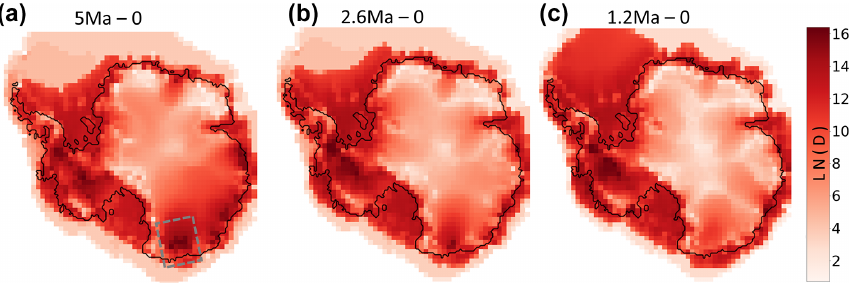
Figure 6. Spatial patterns in the CDF difference metric D between our sensitized and desensitized model simulations (see Sect. 5.2). D is computed from model ice sheet evolution through the last 5 million years (a) , the last 2.6 million years (b) , or the last 1.2 million years (c) . A modern model grounding line is shown in black. The dashed grey box in panel (a) denotes the Wilkes Subglacial